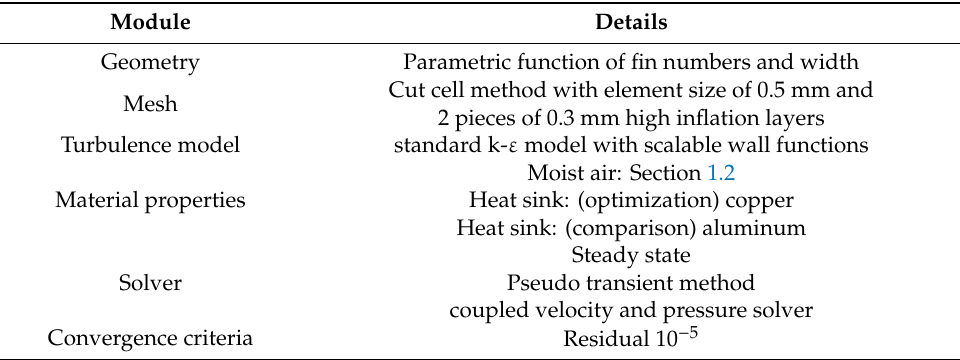
Table 2. Numerical model and solver